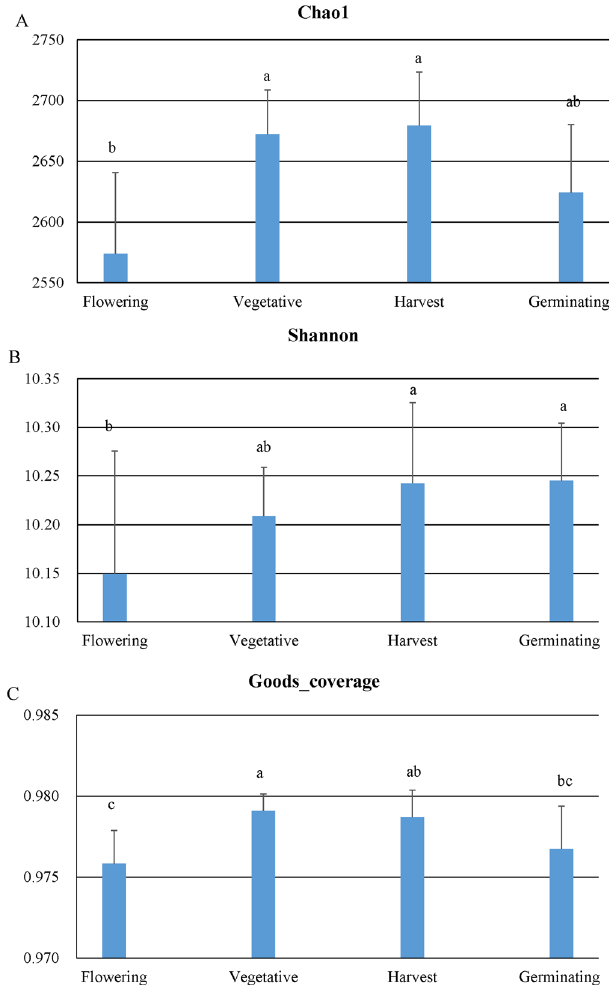
Figure 5. Prokaryotic diversity that significantly changes with Potentilla anserina development. The bars with different letters are significantly different (analysis of variance Tukey post-hoc p < 0.05) from one another. Graphs show mean ± standard error. ( A ) Chao1 index, ( B ) Shannon index and ( C ) Goods_coverage.